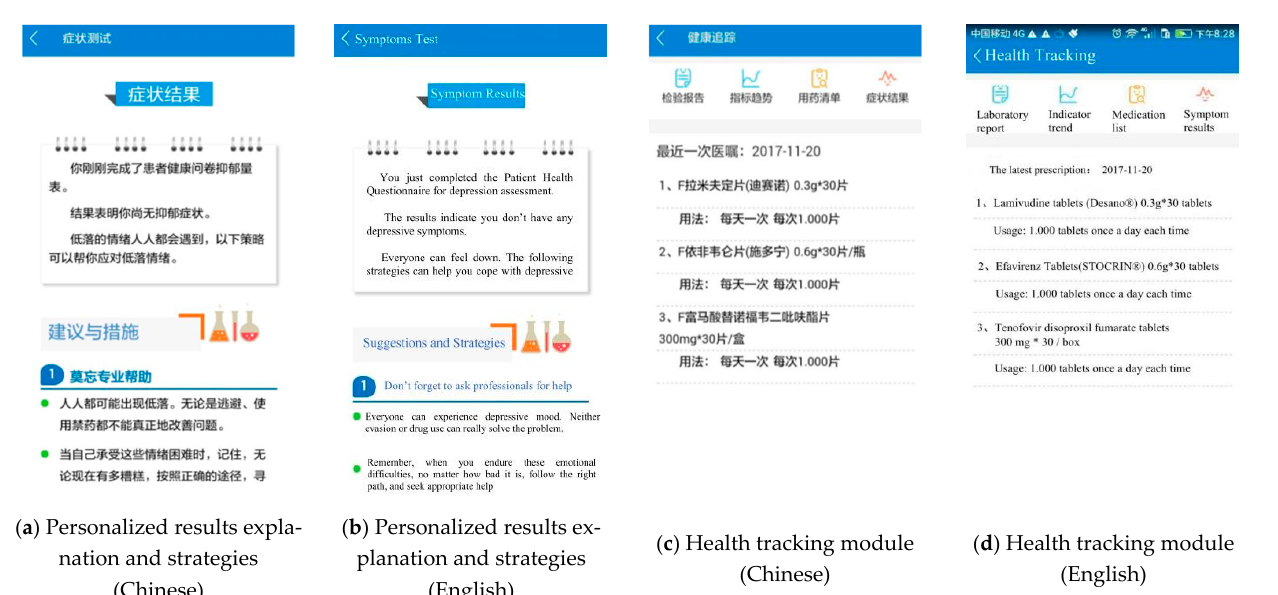
Figure 5. Personalized results explanation and strategies, and the health tracking module.